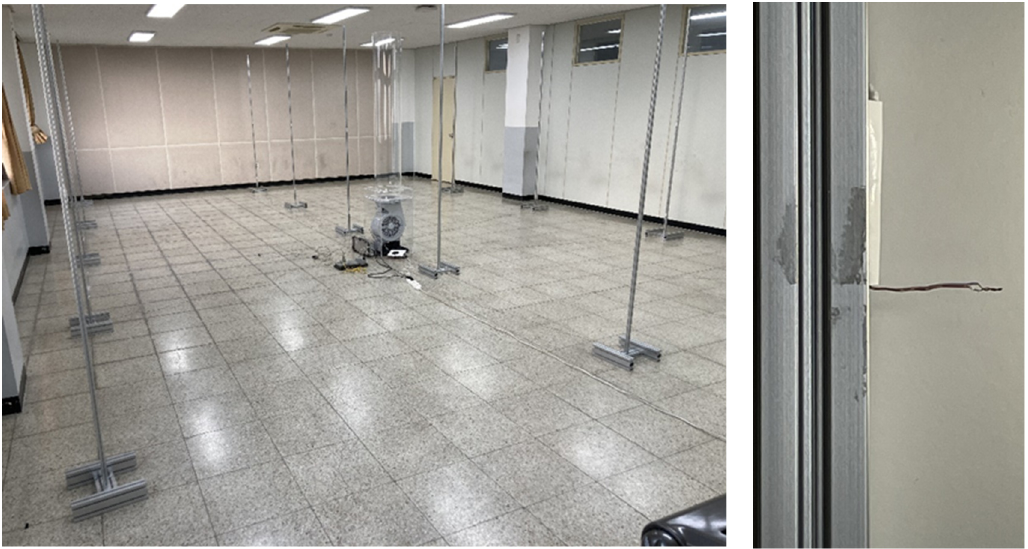
Figure 10. Fifty-four temperature points and air circulation system.